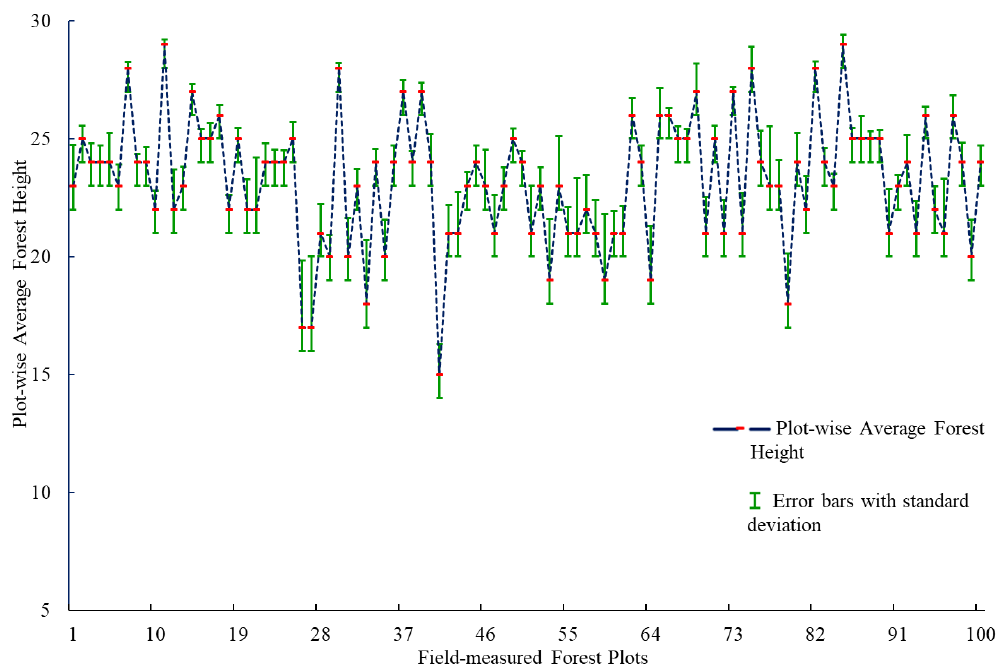
Figure 3. Field-measured plot-wise average forest height with error bars.